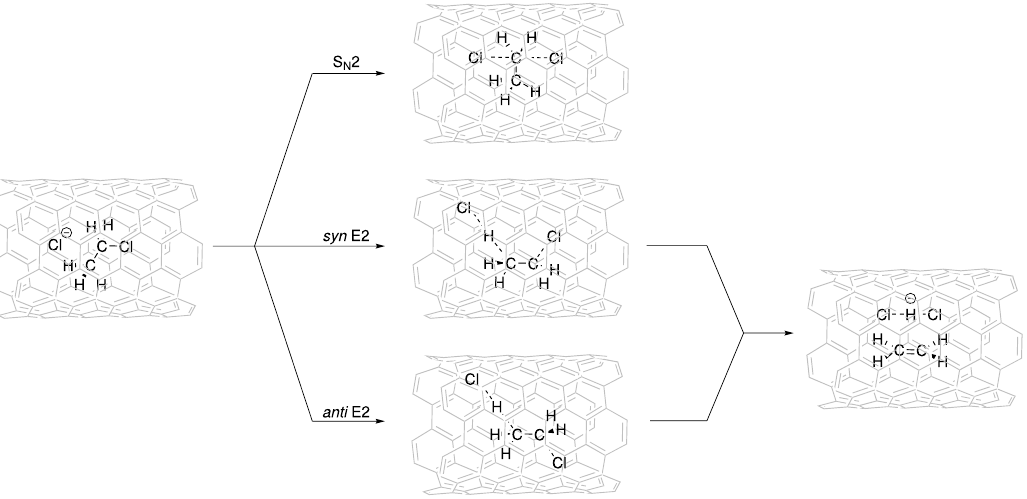
Figure 2. Schematic representation of S N 2, and syn- and anti -E2 mechanisms inside CNTs. The critical points corresponding to the reactant complex (Rx) and the S N 2, and syn - and anti -E2 transition states (TSs) and products (Pds) were fully optimized inside the different CNTs. The activation ( ∆ E ‡ ) and reaction ( ∆ E ) energies of the reactions inside the different-diameter CNTs are reported in Tables 2 and 3. The interactions between the CNT “nanoreactor” and the guest molecules were significantly large. Confinement could lead to either a decrease (catalysis) or increase (inhibition) in the activation energies (Table 2).